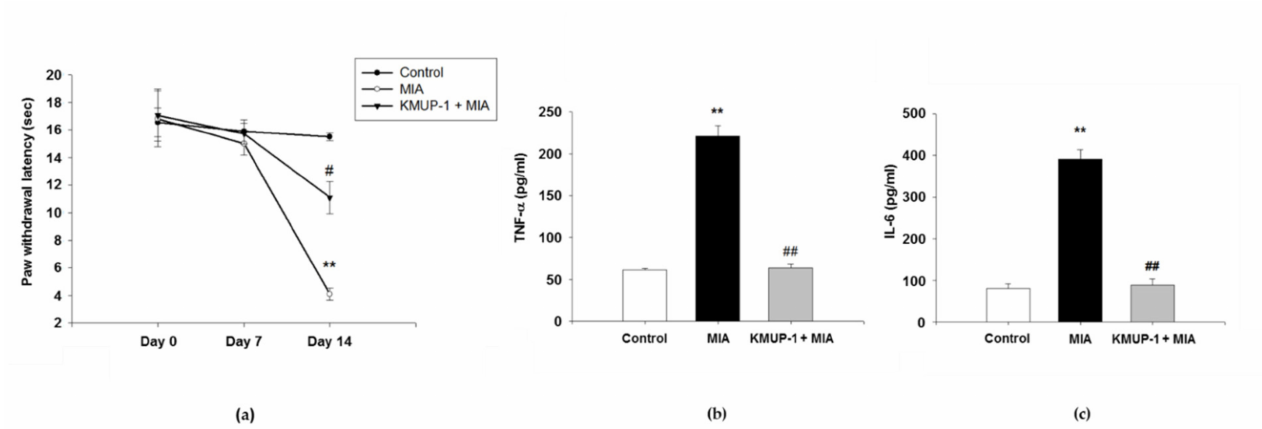
Figure 7. Effects of KMUP-1 on mechanical hyperalgesia and serum levels of inflammatory cytokines in MIA-induced OA rats. ( a ) The paw withdrawal latency (PWL) was measured as described in Section 2. ( b ) The levels of TNF- α and ( c ) IL-6 were evaluated by ELISA assay. Values are presented as mean ± SEM, n = 6. ** p < 0.01 compared to control group. # p < 0.05, ## p < 0.01 compared to MIA